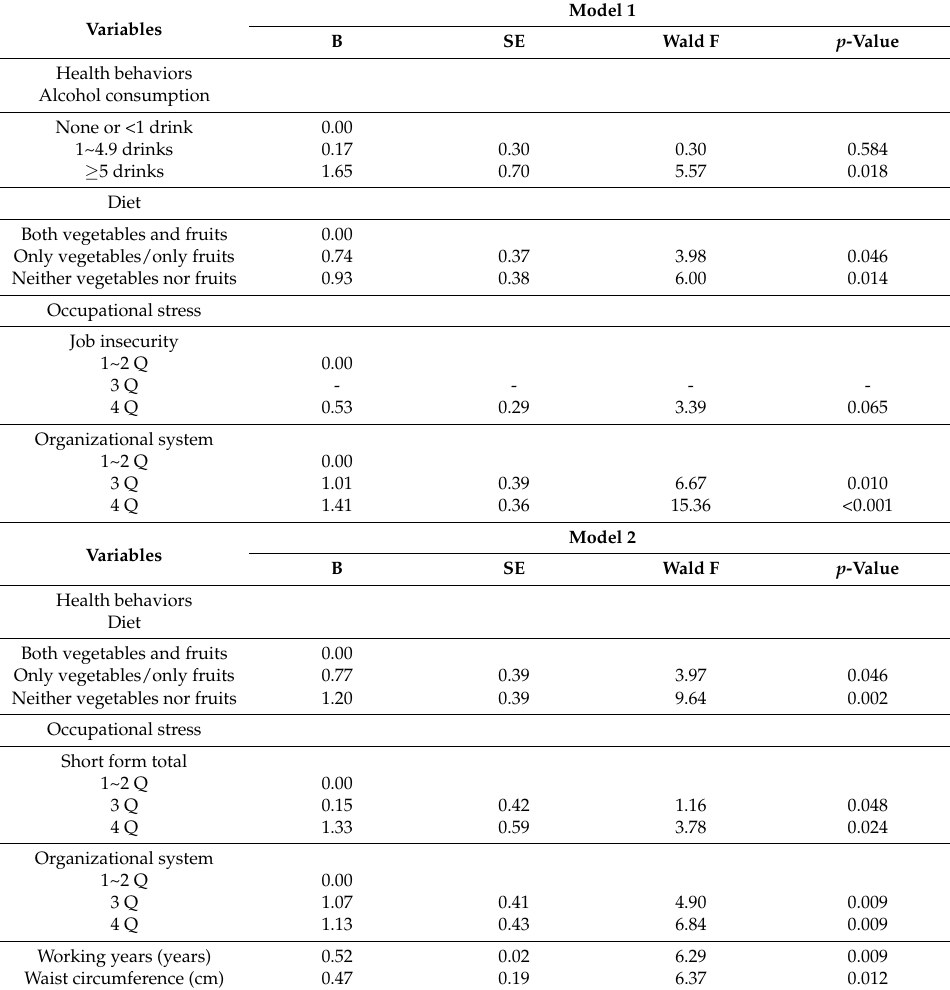
Table 3. Factors Influencing Prediabetic State ( N =